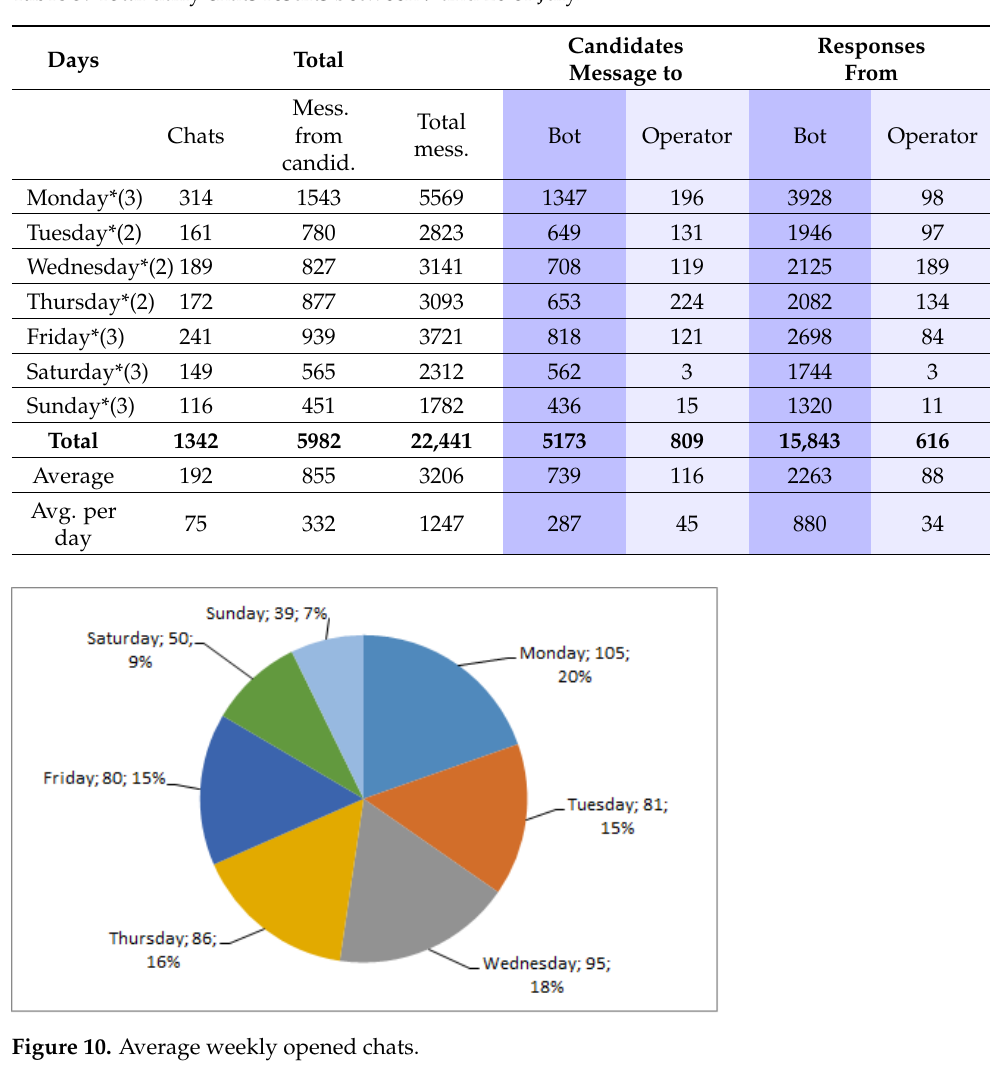
Table 3. Total daily chats results between 9 and 26 of July.